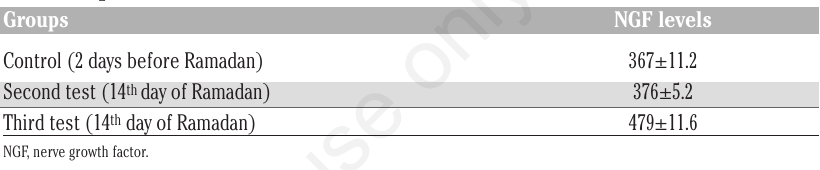
Table 2. Effect of fasting on nerve growth factor levels in the group of women only. All data are expressed as means±standard error of mean; P<0.05. Groups